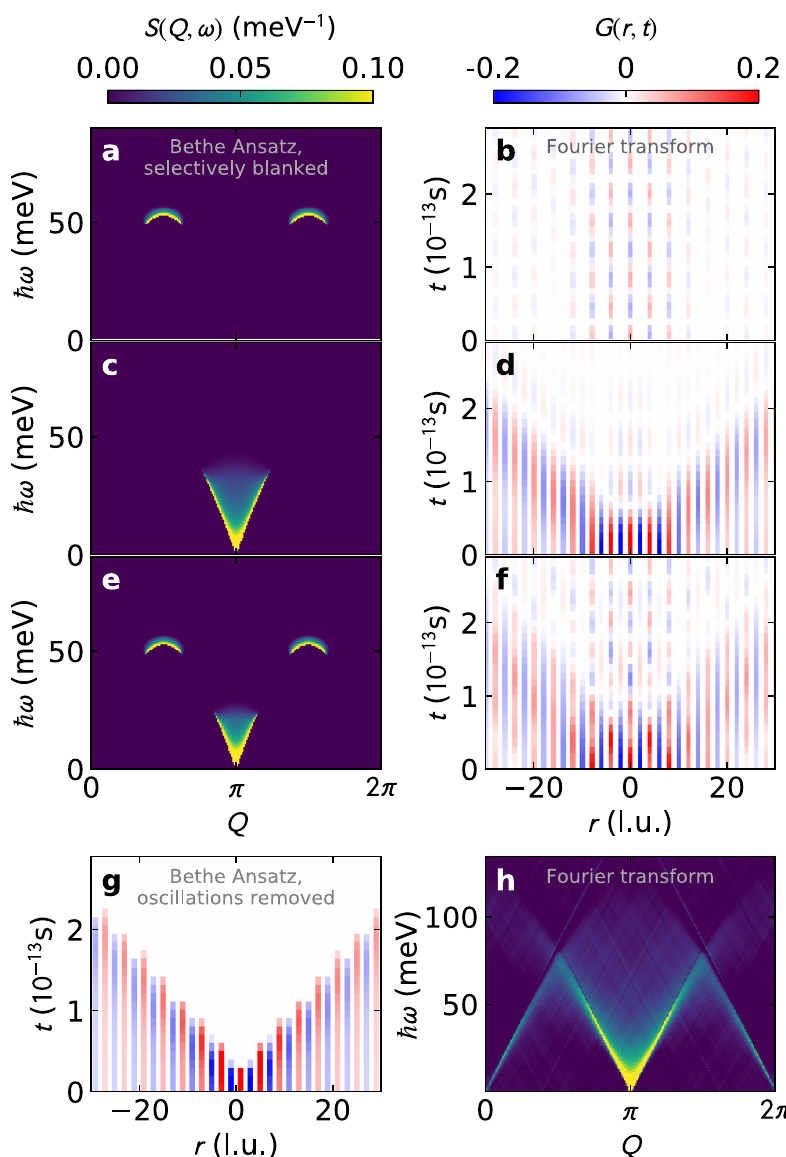
Fig. 3 | Signal analysis of the Bethe Ansatz. The right column is the Fourier Transform of the left. a , c , e The Bethe Ansatz with everything removed but key features at Q = π or Q = π /2. b , d , f The resulting Fourier transform of these spectra into real space and time. This clearly shows that the oscillations above the light cone are due to the stationary Q = π /2 states, while the light cone is due to the